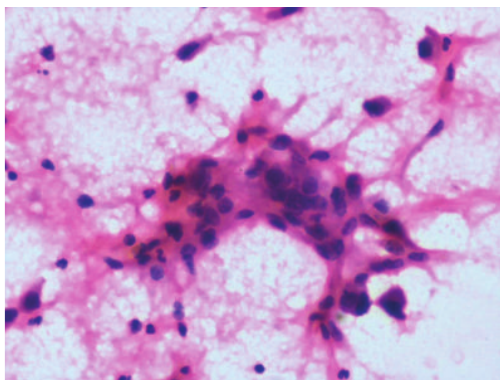
Figure 6: Cytological smear from lung tumor showing dysplastic cells in inflammatory background suggestive of squamous cell carcinoma.